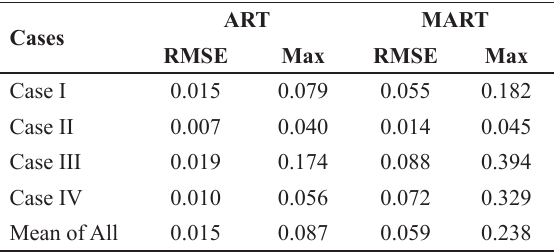
RMSE and maximum discrepancy of TEC estimation by ART and MART. The units are in